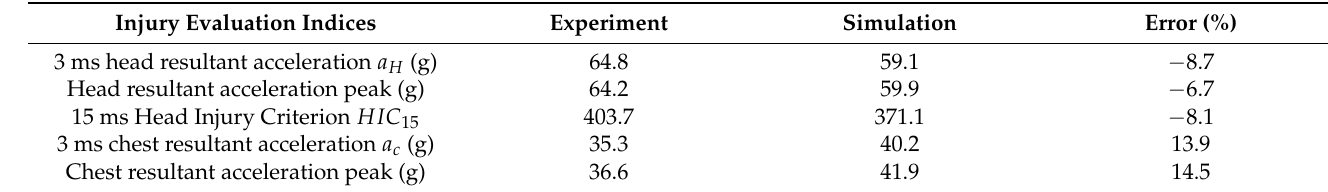
Figure 4. Comparison of ( a ) head resultant acceleration and ( b ) chest resultant acceleration between test and simulation. Table 1. Comparison of dummy injury evaluation indices in simulation and test.